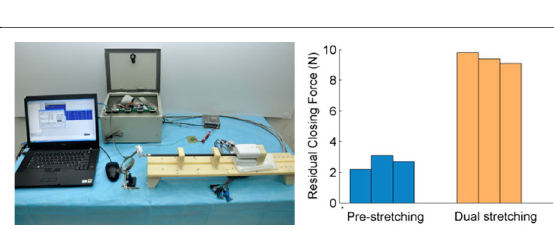
Figure 11 Pre-stretching vs. dual stretching methods for the residual clamping force